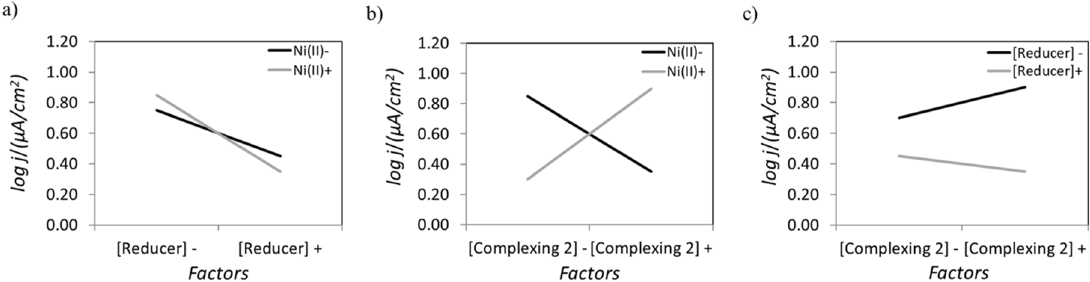
Figure 8. Interaction plots for some of the factors considered in the L 8 matrix for ( a ) Ni (II) and reducing agent, ( b ) Ni (II) and complexing agent 2, and ( c ) reducing agent and complexing agent 2 concentrations.